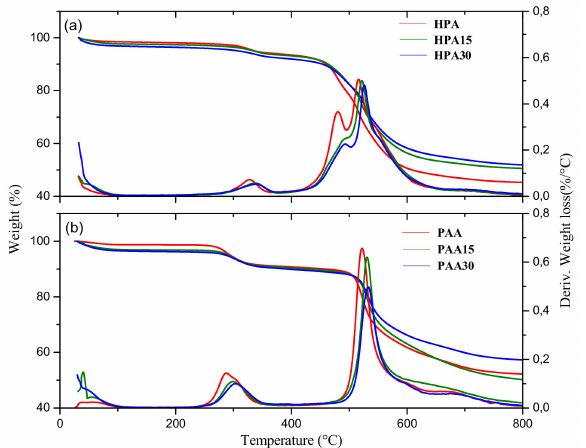
Figure 4. TGA curves of ( a ) HPA and ( b ) PAA and MMMs made from them, with PPN as the